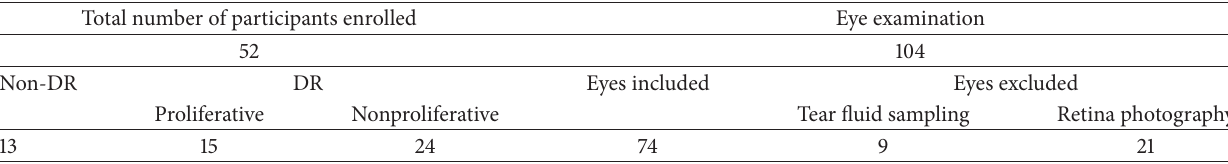
Table 1: Characteristics of the